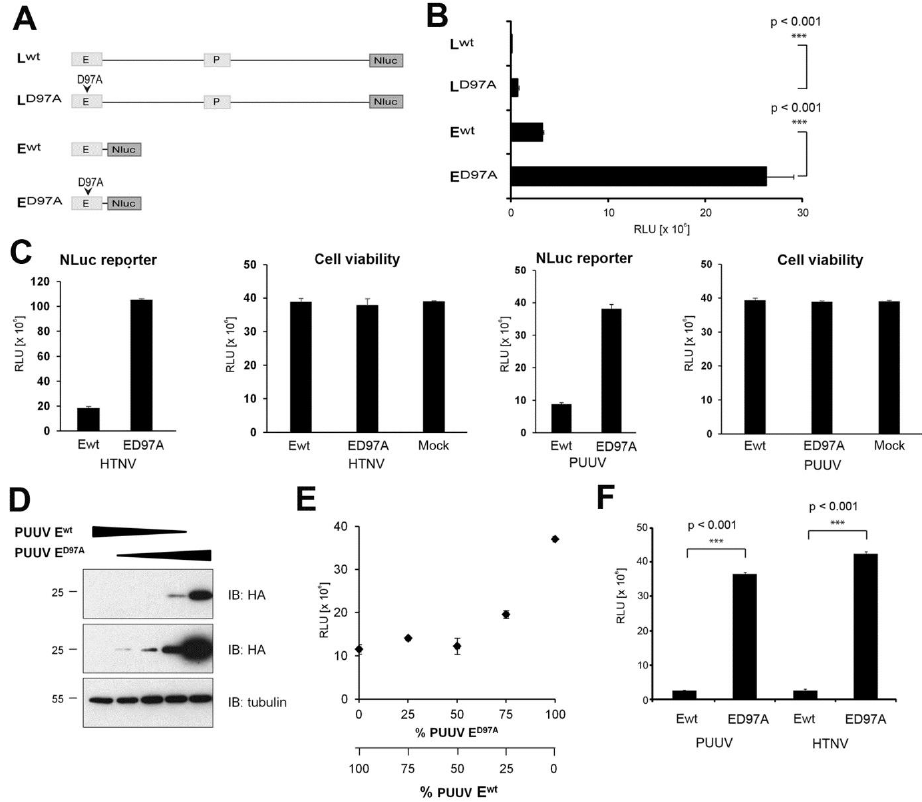
Figure 5. Development of a cell-based assay for endonuclease activity. ( A ) Schematic representation of the constructs. Full-length L protein wt and D97A mutant, as well as the endonuclease domain (E) wt and D97A mutant were fused to NLuc at the C-terminus. ( B ) The constructs were expressed in BSR T7/5 cells. Cells were lyzed 48 h post-transfection and NLuc activity measured using the Nano Glow ® Luciferase Assay System (Promega). Data represent mean ˘ SD ( n = 3) and were analyzed by one-way ANOVA. One representative experiment out of three is shown. ( C ) Cell viability assay. The indicated NLuc fusion constructs were transfected into BSR T7/5 cells. After 24 h, NLuc reporter activity was measured as in ( B ). Cell viability was assessed by Cell TiterGlo ® assay. Data represent mean ˘ SD ( n = 3). ( D ) Different relative amounts of PUUV Ewt-HA and PUUV ED97A-HA were co-transfected into BSR T7/5 cells. At 24 h post transfection, protein expression was detected in Western blot as in Figure 2B. ( E ) Different relative amounts of PUUV Ewt-NLuc and PUUV ED97A-NLuc were co-transfected into BSR T7/5 cells and NLuc reporter activity detected after 24 h as in ( B ). Data represent mean ˘ SD ( n = 3). ( F ) PUUV Ewt and HTNV Ewt and the corresponding D97A mutants were fused to NLuc at the C-terminus. All constructs were expressed as in ( B ). Cells were lyzed 24 h post-transfection and NLuc activity measured. Data represent mean ˘ SD ( n = 3) and were analyzed by one-way ANOVA with p -values indicated. One representative experiment out of three is